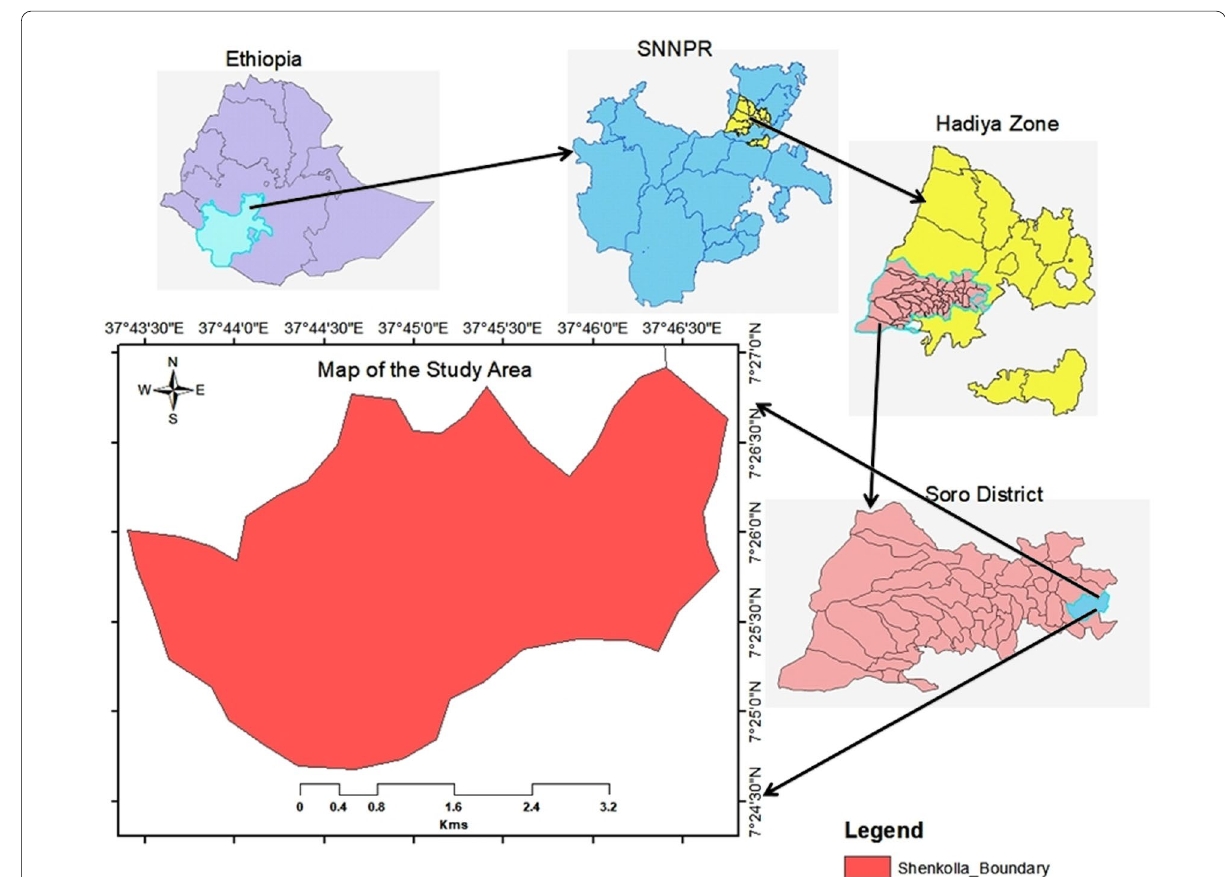
Fig. 1 Location map of the study area, Shenkolla within the South Central